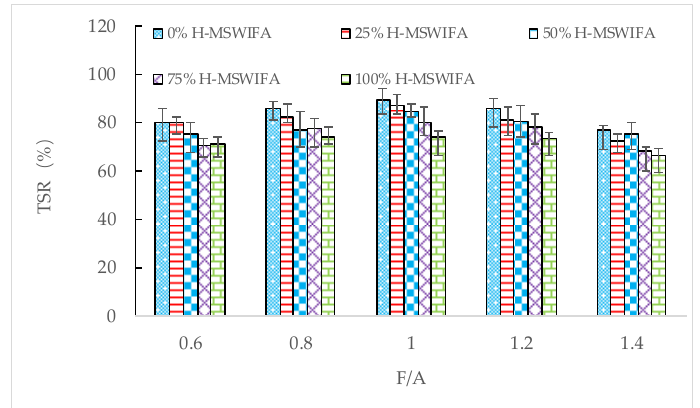
Figure 15. The TSR of AC-13.